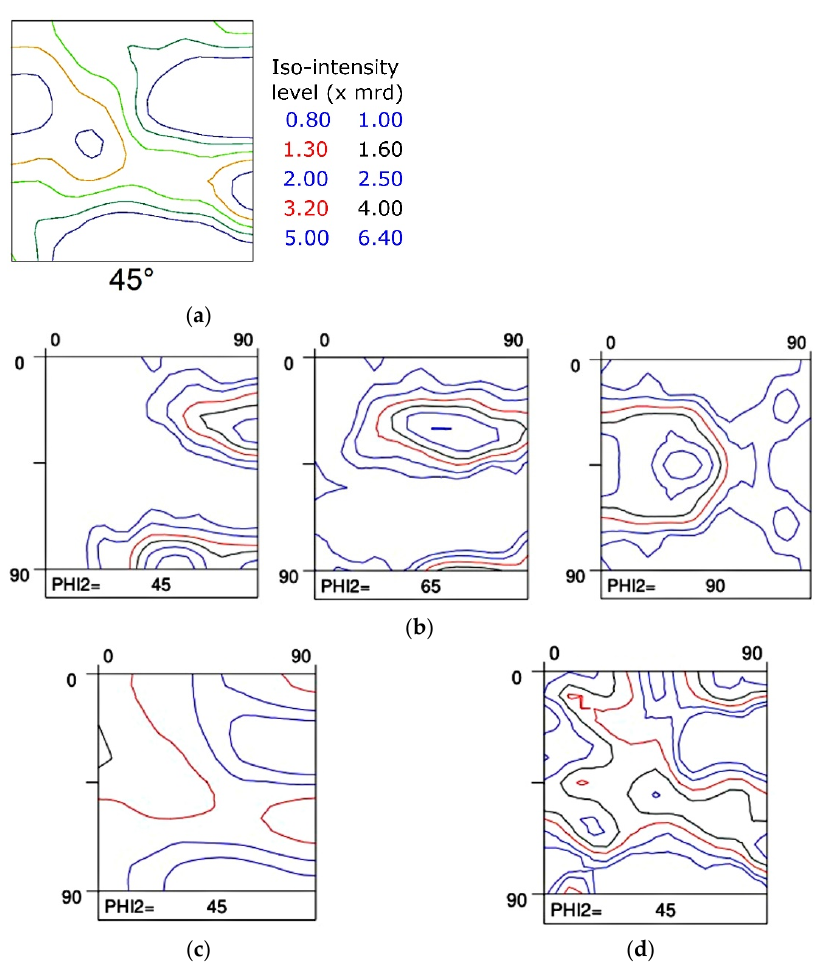
Figure 6. ( a ) Measured product martensite texture corresponding to Figure 5a; ( b ) Reconstructed austenite texture corresponding to the map in Figure 5b; Simulated product texture ( c ) without variant selection and ( d ) applying the double YKS variant selection rule. Level lines: 0.8–1.0–1.3–1.6–